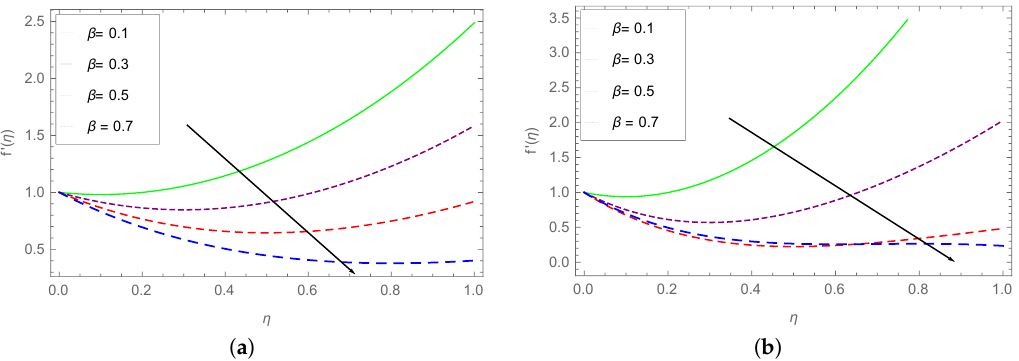
Figure 2. ( a ) Impact of β on f (cid:48) ( η ) , when (cid:101) = 0.4, S = 0.2 and ( b ) Impact of β on f (cid:48) ( η ) , when (cid:101) = 0.01, S = 0.05.